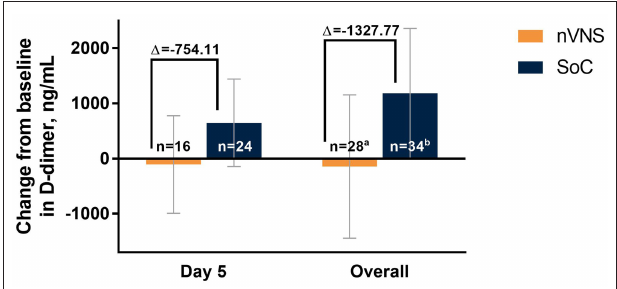
FIGURE 6 | Changes From Baseline in Levels of D-Dimer by Treatment Group Among Hospitalized Patients With COVID-19. Error bars denote 95% CIs. a 40 observations from 28 participants. b 50 observations from 34 participants. COVID-19 indicates coronavirus disease 2019; LSM, least squares